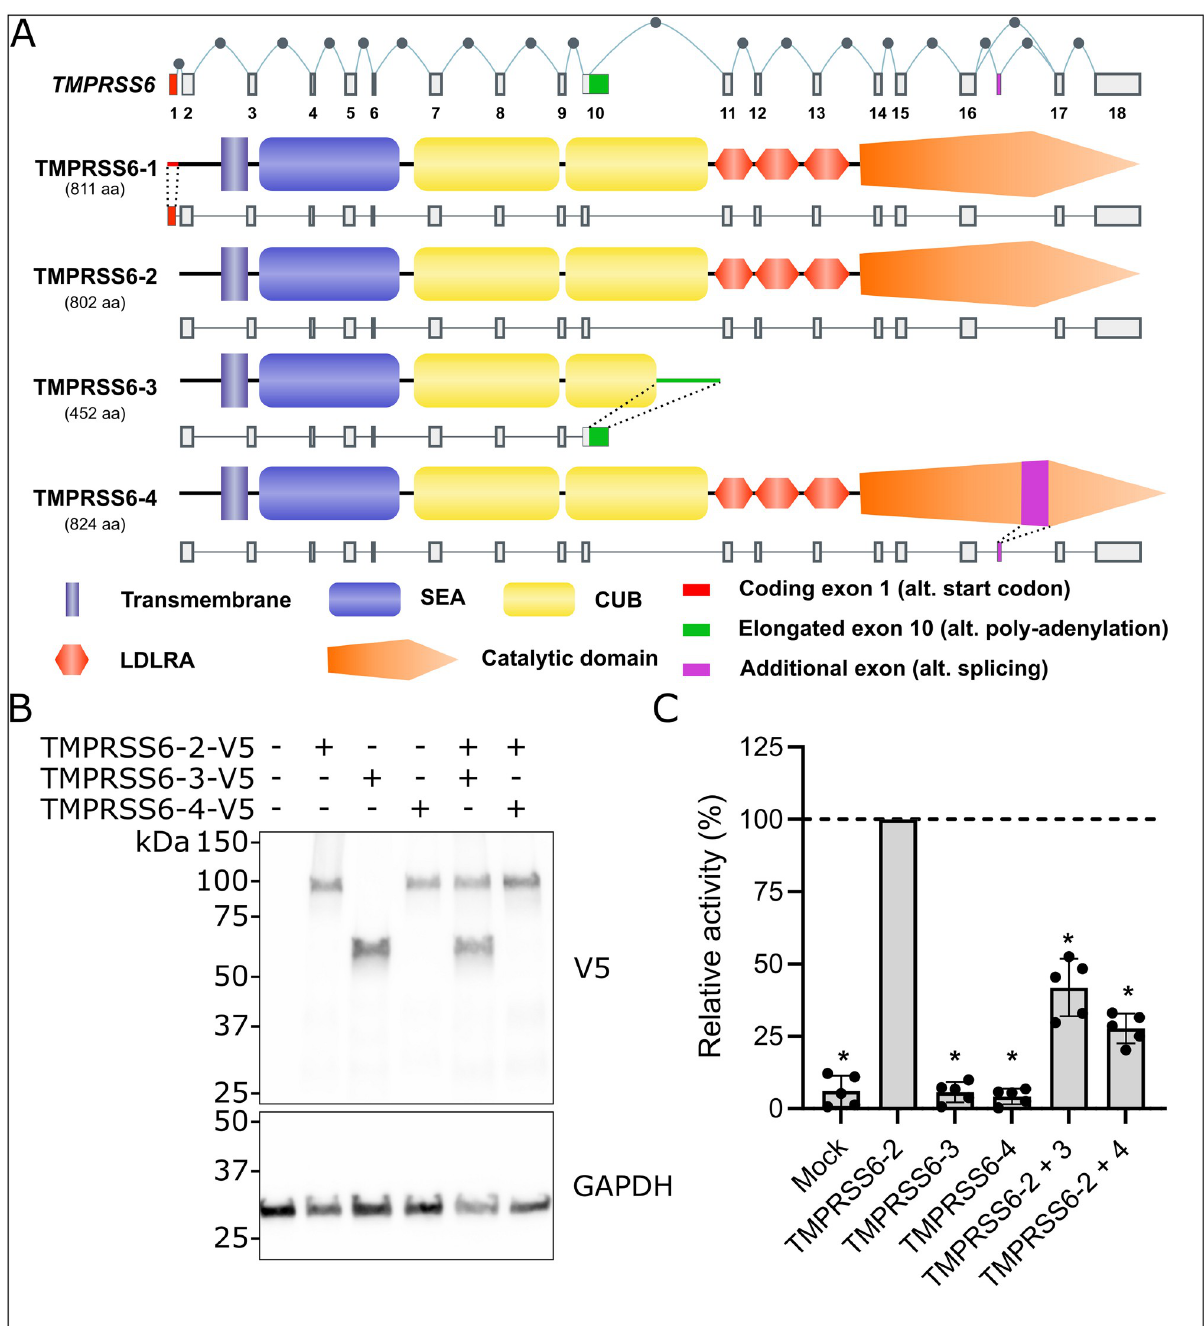
Fig 1. TMPRSS6 isoforms 3 and 4 reduce isoform 2 activity. A) TMPRSS6 isoforms representation adapted from our previous publication [1] licensed under CC BY 3.0. B) Expression of TMPRSS6 V5-tagged isoforms 2, 3 and 4 in transfected HEK293 cells assessed by western blotting against V5. C) Proteolytic activity was measured in the cell medium of HEK293 cells transfected with one or two TMPRSS6 V5-tagged isoforms. Boc- QAR-AMC (200 μ M) fluorogenic substrate cleavage was monitored. Results are presented as relative activity over TMPRSS6 isoform 2 (TMPRSS6-2) activity. Statistical significance was assessed using one sample T test, � p < 0.0002 (n =